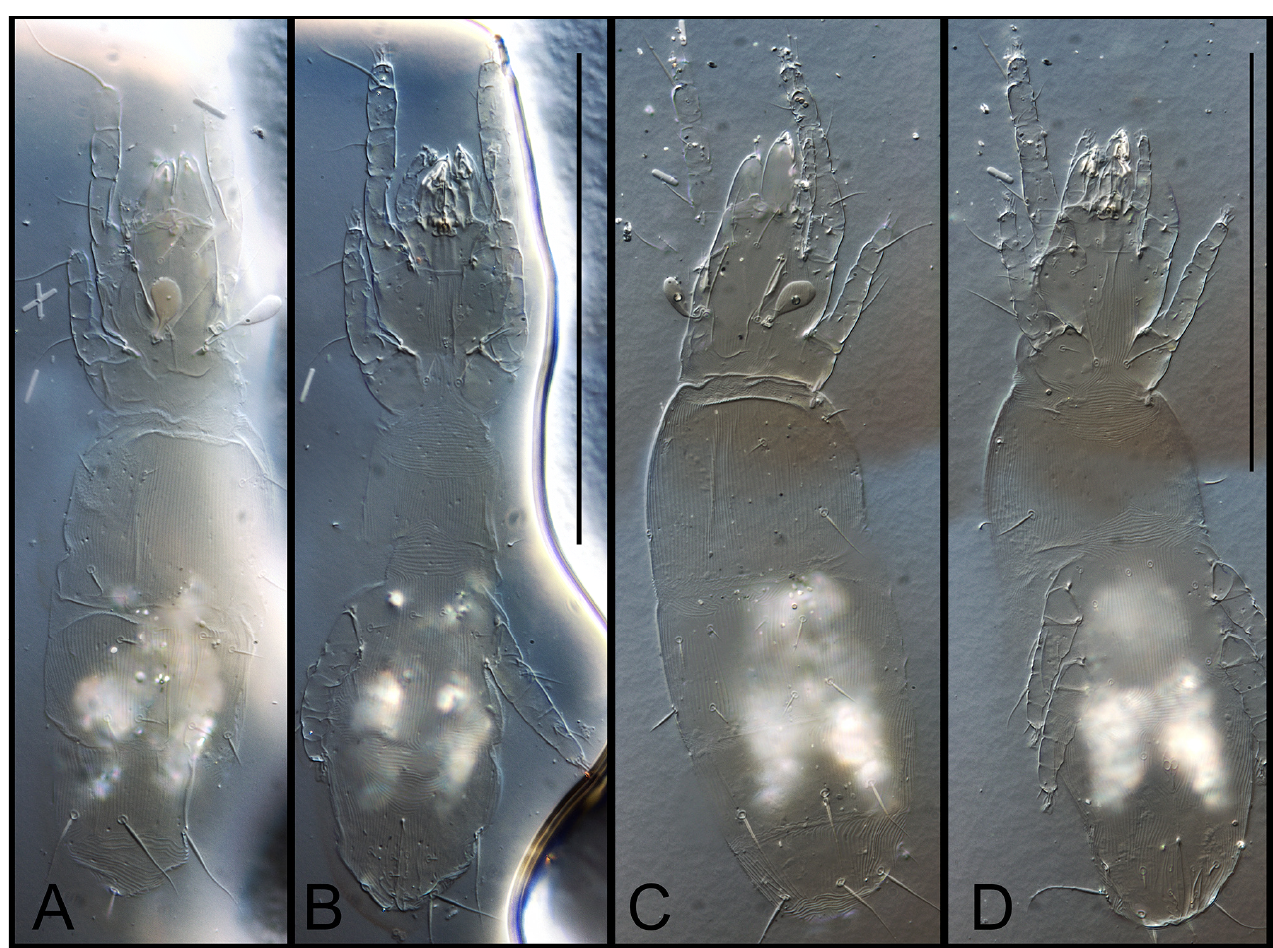
Figure 5. Paralycus daeira sp. n., larva ( A , B ) and protonymph ( C , D ), light microscope images: ( A , C )—dorsal view; ( B , D )—ventral view. Scale bar 100 µm.